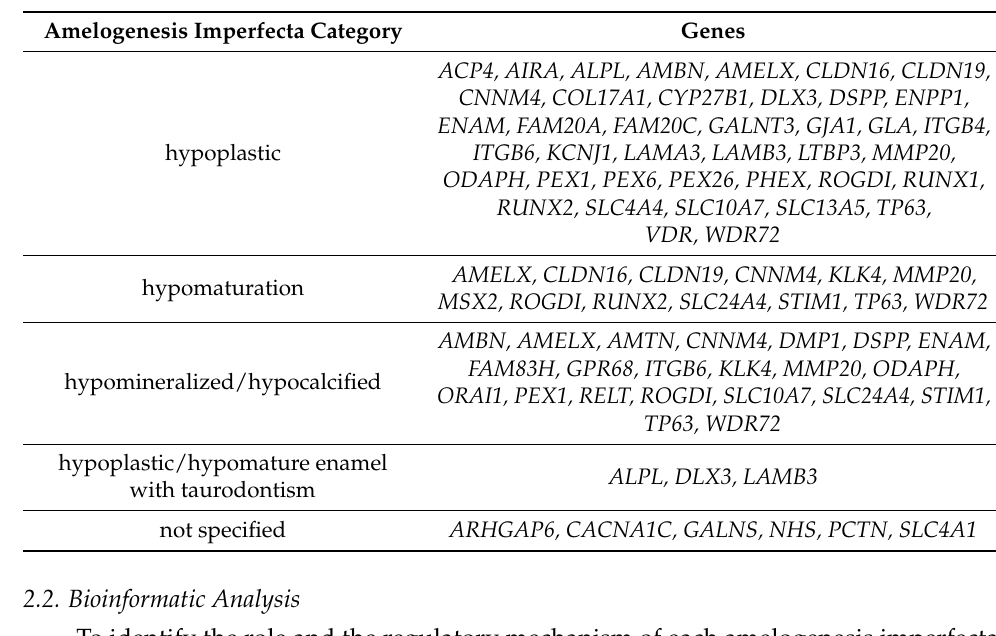
Table 3. Genes grouped by amelogenesis imperfecta phenotype.